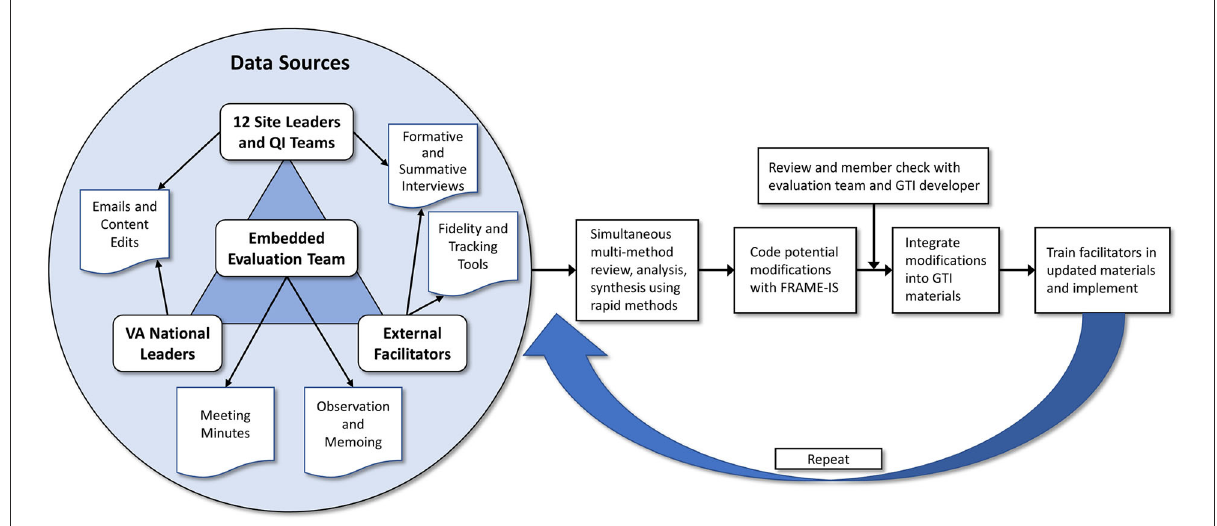
FIGURE1 Process to identify, analyze, and integrate modifications to Getting To